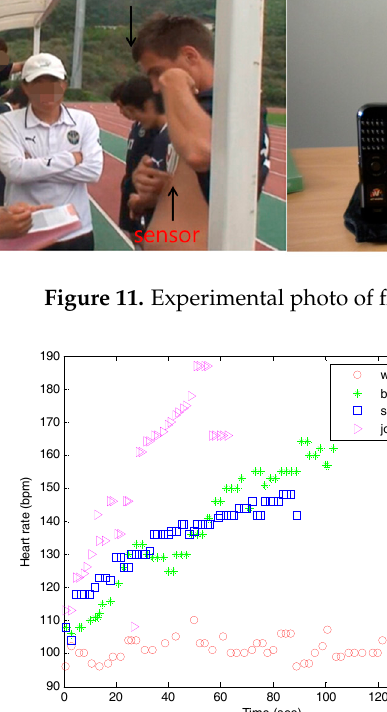
Table 3. Procedure for field test.